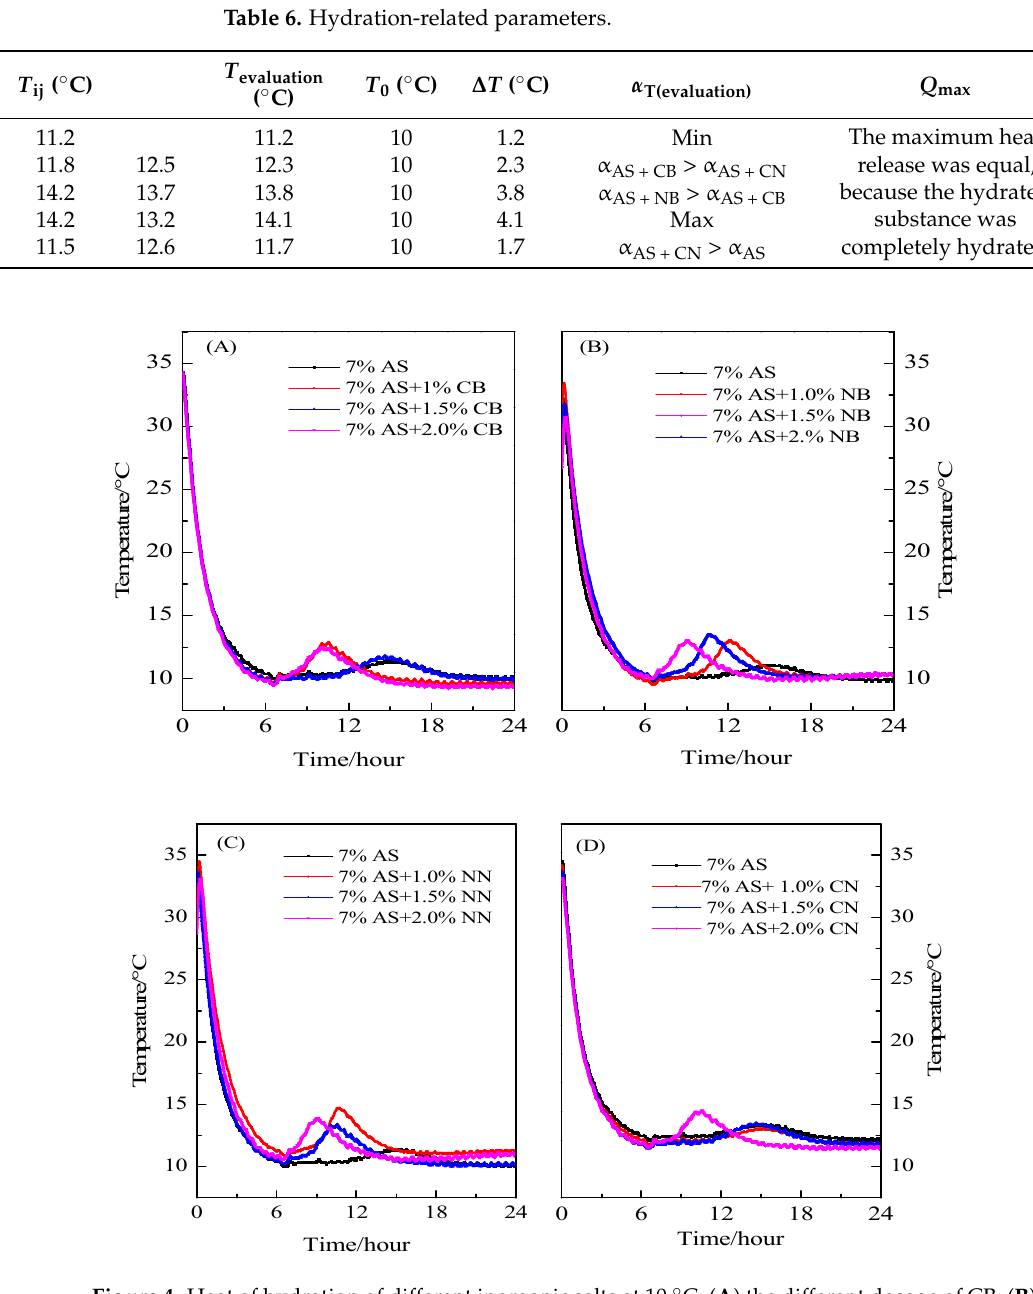
Figure 4. Heat of hydration of different inorganic salts at 10 °C: ( A ) the different dosage of CB; ( B ) the different dosage of NB; ( C ) the different dosage of NN; ( D ) the different dosage of CN.